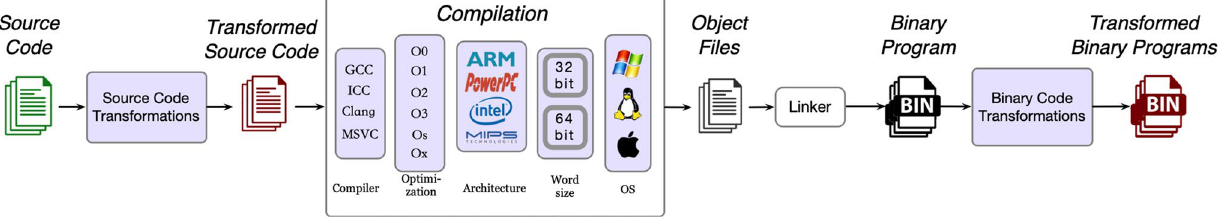
Fig. 1 Illustration of compilation